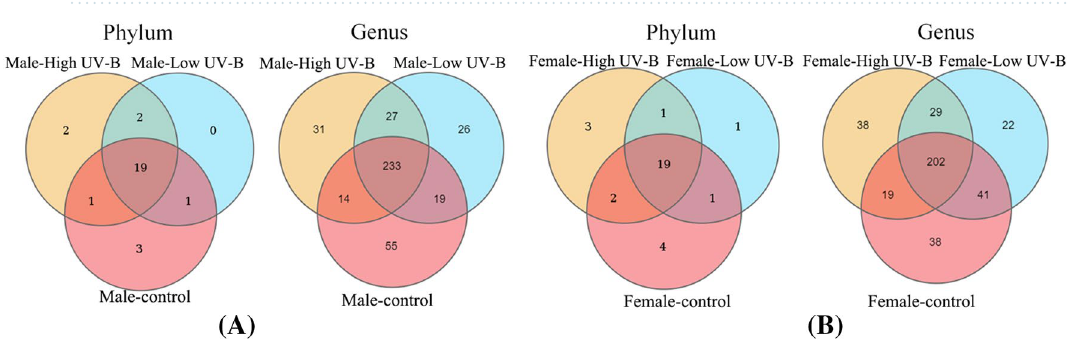
Figure 5. Effects of increased UV-B radiation on the top 12 phyla ( A ) and top 12 genera ( B ) of the epiphytic bacteria on the S. thunbergii males and females.